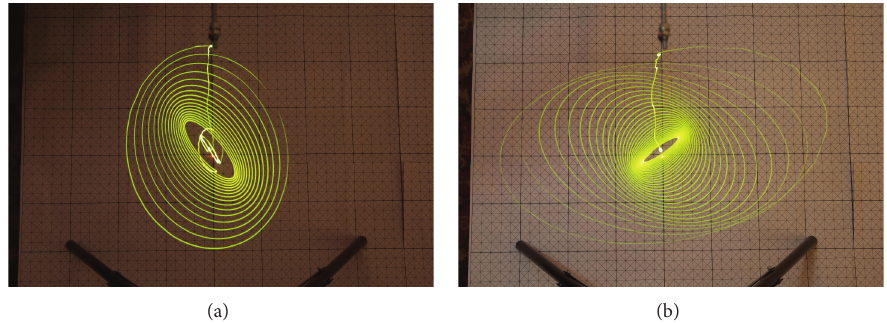
Figure 6: Experimental trajectories of the spherical pendulum with fixed pivot center and fixed cable length 𝑙 = 0.825 m (a; b).